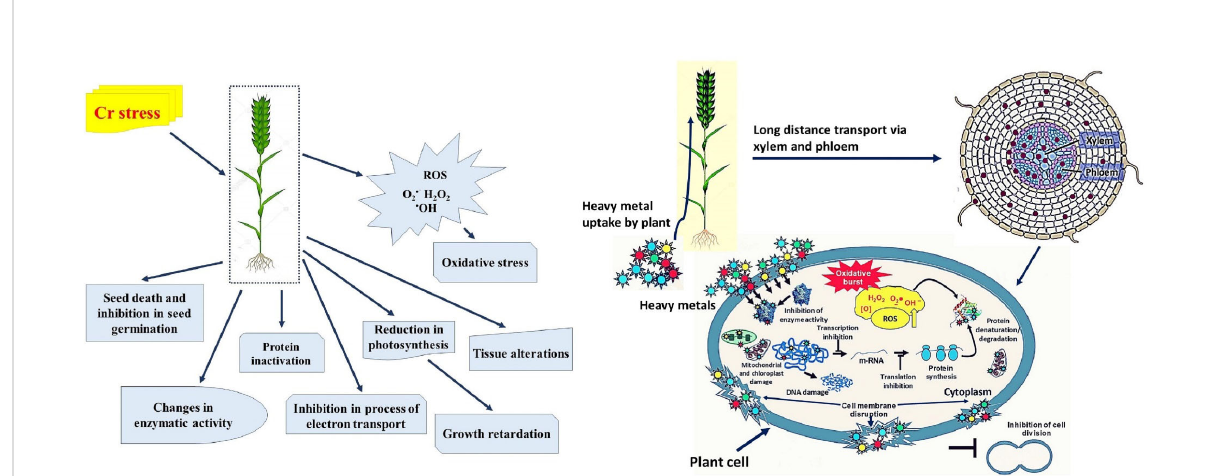
FIGURE 2 Schematic representation from the sequestration of chromium (Cr) into a plant cell to the plant ’ s death, through a series of events. Cr toxicity decelerates photosynthesis by preventing seedling establishment and root growth, which in turn slows down essential nutrient and water uptake. Moreover, toxicity of Cr alters photosynthetic pigments content in plant leaves, and these alterations typically result in chlorosis and necrosis of the leaves. In addition, to decreasing membrane integrity, high Cr stress also causes the loss of osmolytes and cell turgor pressure, which causes stomatal closure impacting overall osmoregulation. Additionally, Cr toxicity disrupts the equilibrium between the generation of reactive oxygen species (ROS) and the antioxidant defense system, which causes ROS to build up and cause oxidative damage to